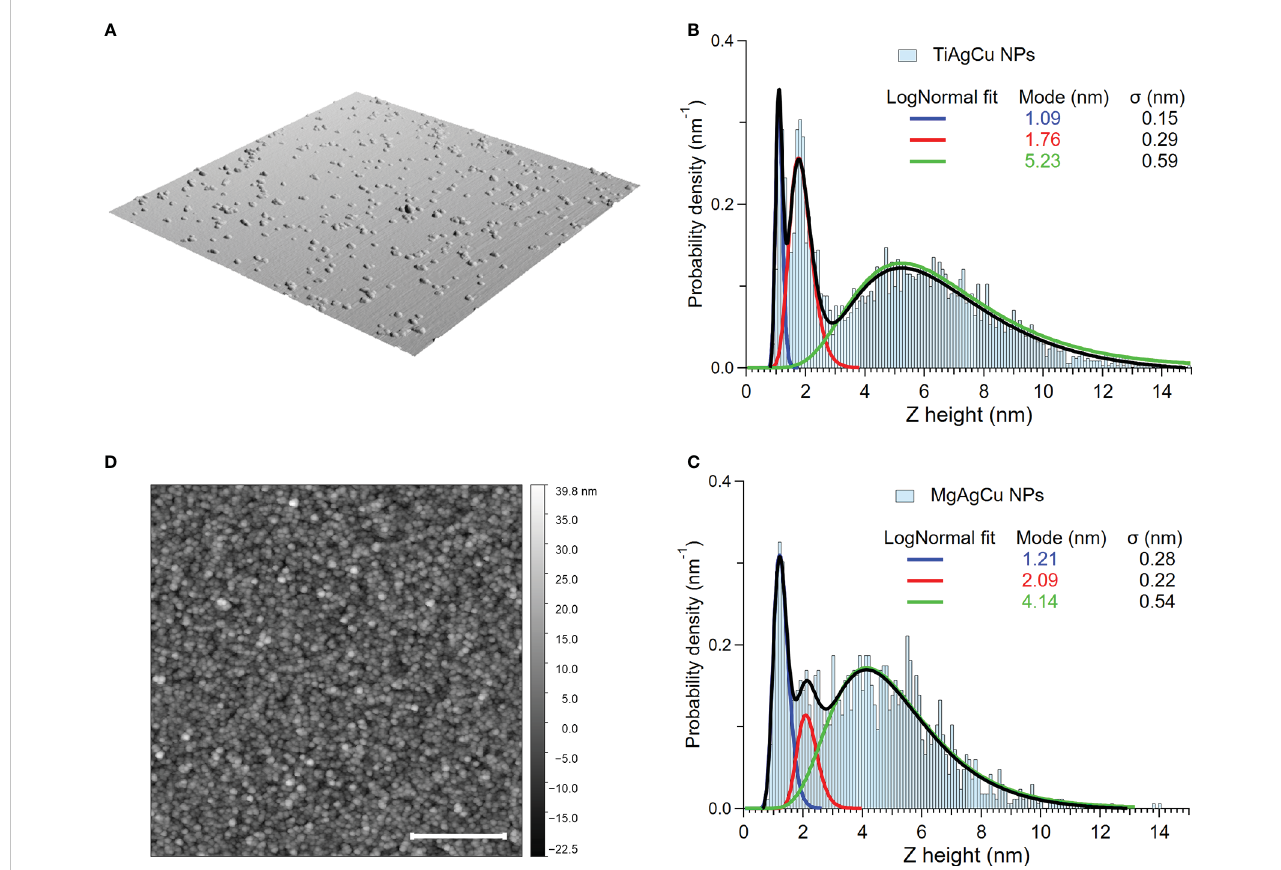
FIGURE 1 Morphological characterization of the NPs and of the fi lms resulting from the NP deposition. (A) Three-dimensional representation of a typical 2x2 µm 2 AFM image taken on sparse NPs of both compounds deposited on a smooth Si(100) surface. These data were used to obtain the histograms reported in panels (B) and (C) . (B) Distribution of the Ti-Ag-Cu NP height, with the three-modal fi t obtained with lognormal distributions and the corresponding modes. (C) Distribution of the Mg-Ag-Cu NP height, with the three-modal fi t obtained with lognormal distributions and the corresponding modes. (D) Typical 4x4 µm 2 AFM image taken on the 12 nm thick coating. Scale bar